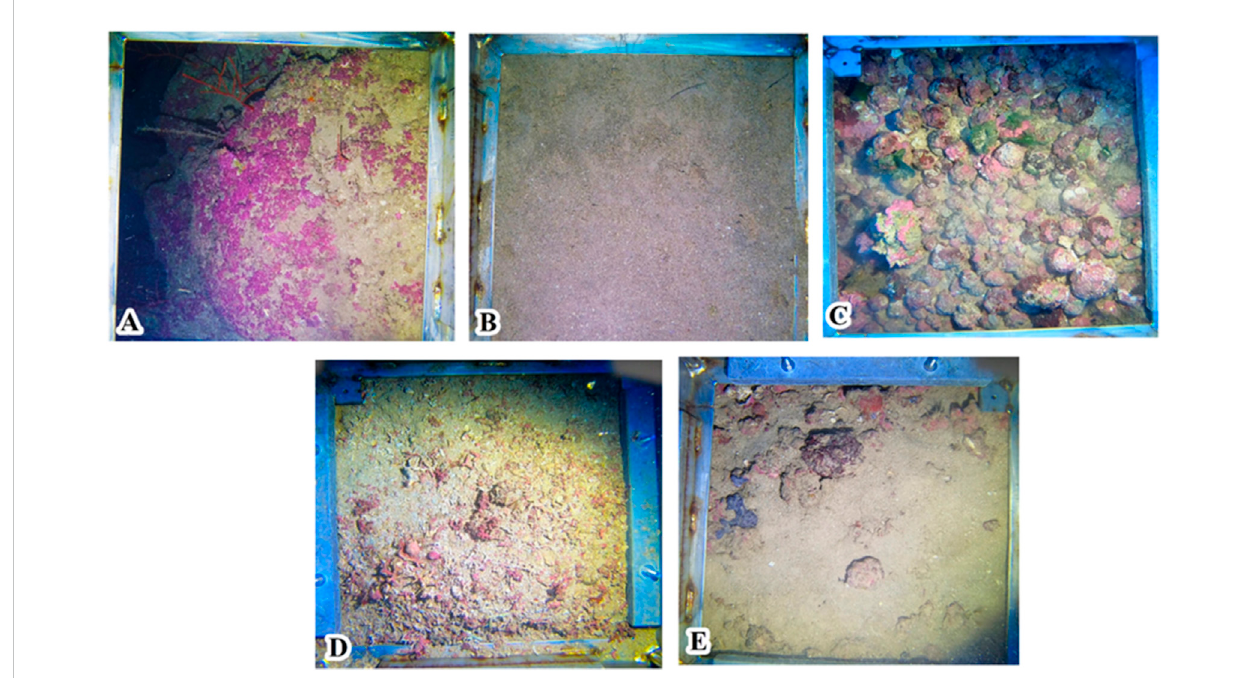
FIGURE 4 Seabedimagesrepresentingthe fi veseabedclassesderivedfromthevideofootage: (A) Bioencrustation(BIOC); (B) Unconsolidatedsediment(SED); (C) Rhodoliths (R > 40%); (D) Mäerl; and (E) Rhodoliths with sediments (R <